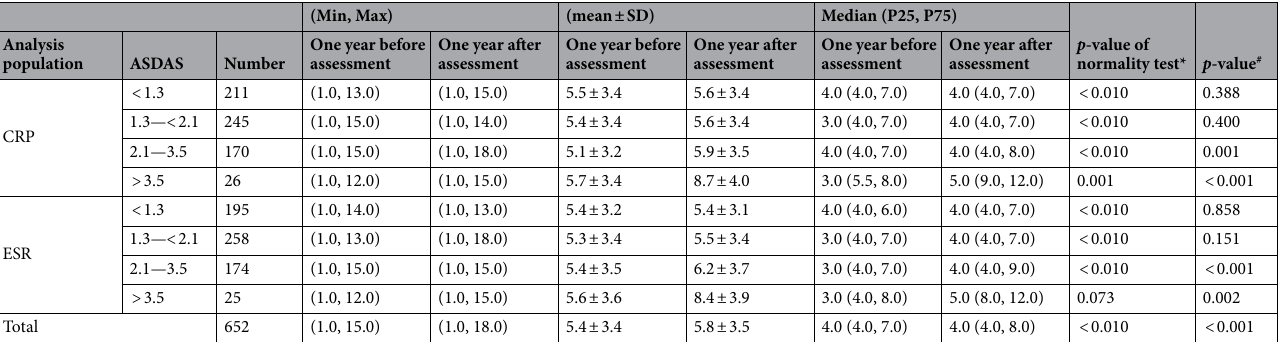
Table 2. Frequency of outpatient visits before and after the first EMRMS assessment (n = 652). *Normality test: When number is ≤ 50, the Shapiro–Wilk test is used; when number is > 50, the Kolmogorov–Smirnov test is used. # When normality test p value is > 0.05, the pair -t test is used; when normality test p value is < 0.05, the Wilcoxon Signed Rank test is used. Abbreviations: ASDAS Ankylosing Spondylitis Disease Activity Score, CRP C-reactive protein, ESR erythrocyte sedimentation rate.